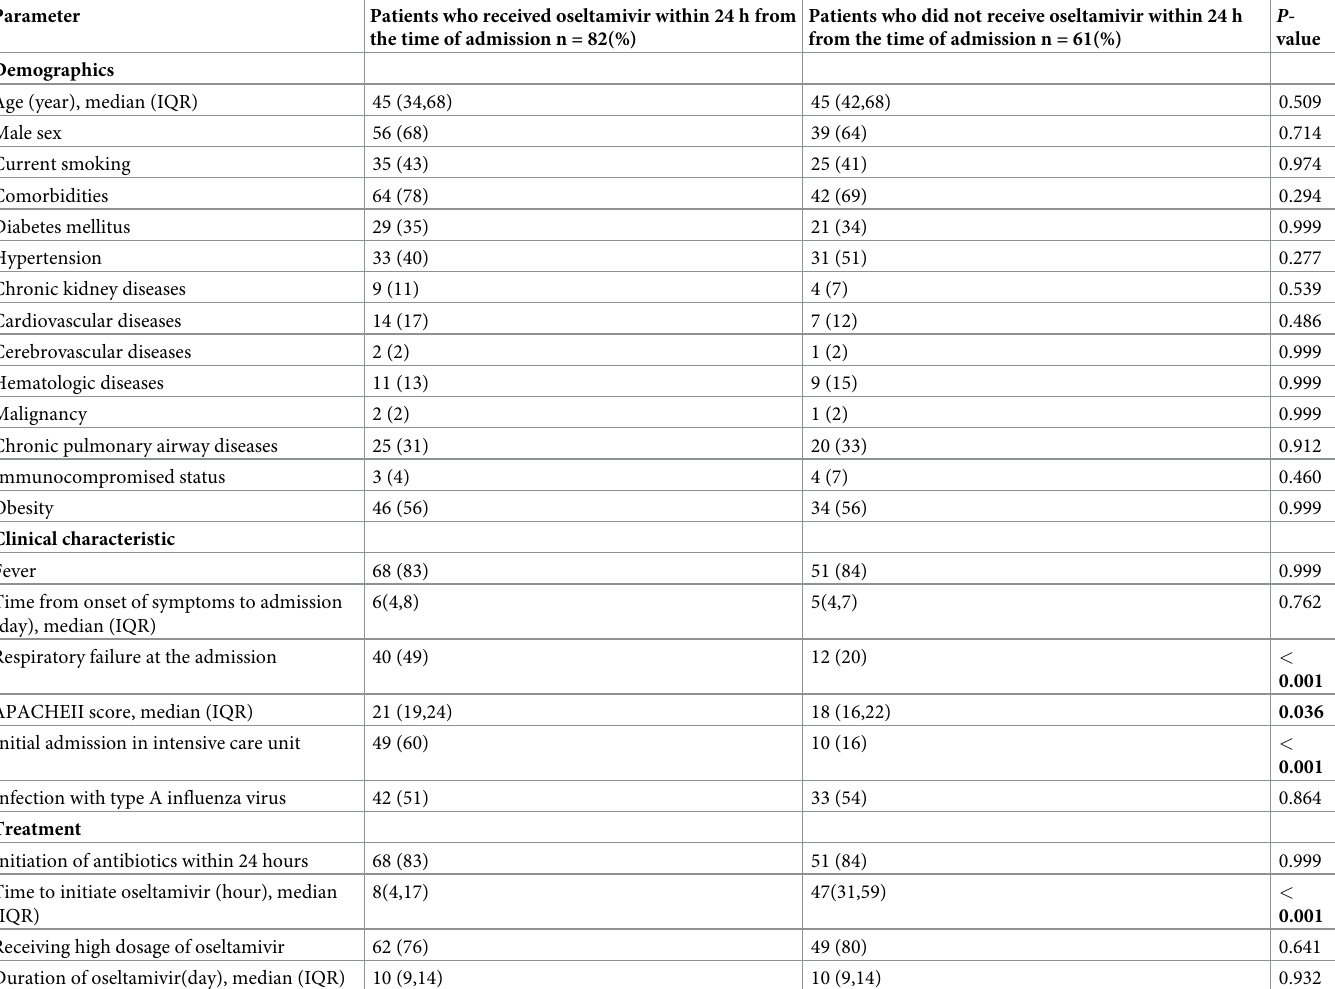
Table 1. Comparison of clinical features between patients with community-acquired influenza pneumonia who received oseltamivir within 24 h from the time of admission and those that received later than 24 h.